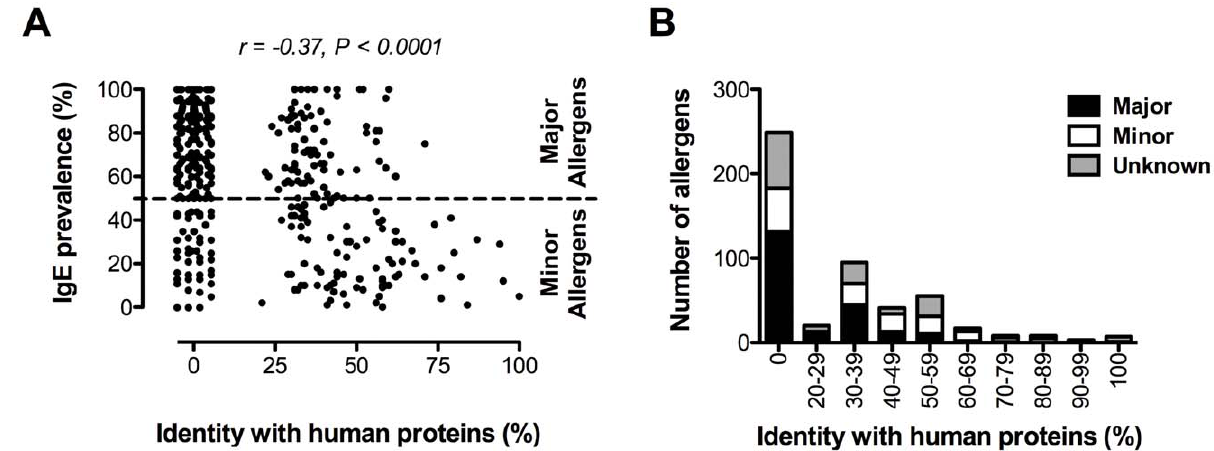
Figure 5. High levels of amino acid identity with human proteins are associated with decreased allergenicity. A , The prevalence of IgE to a natural purified or recombinant allergen (each dot represents a single allergen) and B , the absolute number of allergens (major, minor or unknown prevalence) as a function of the % amino acid identity with homologous human proteins (x-axis). Dotted line (A) separates major and minor